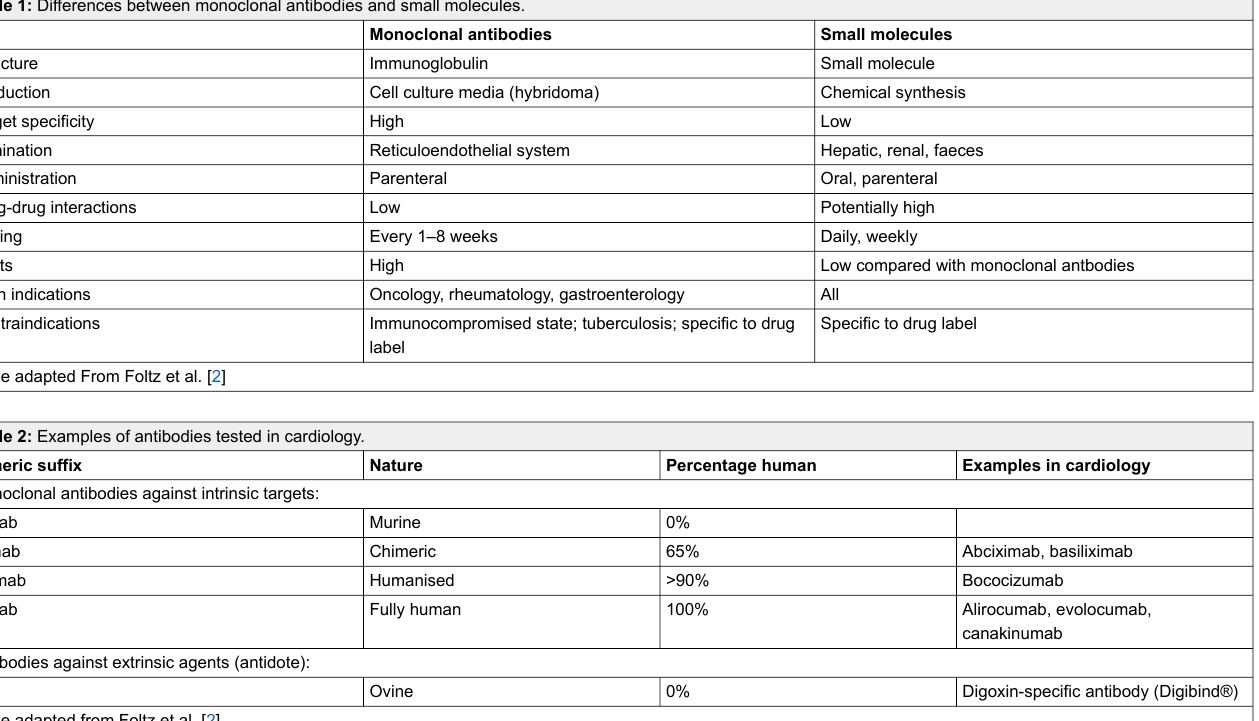
Table adapted from Foltz et al.